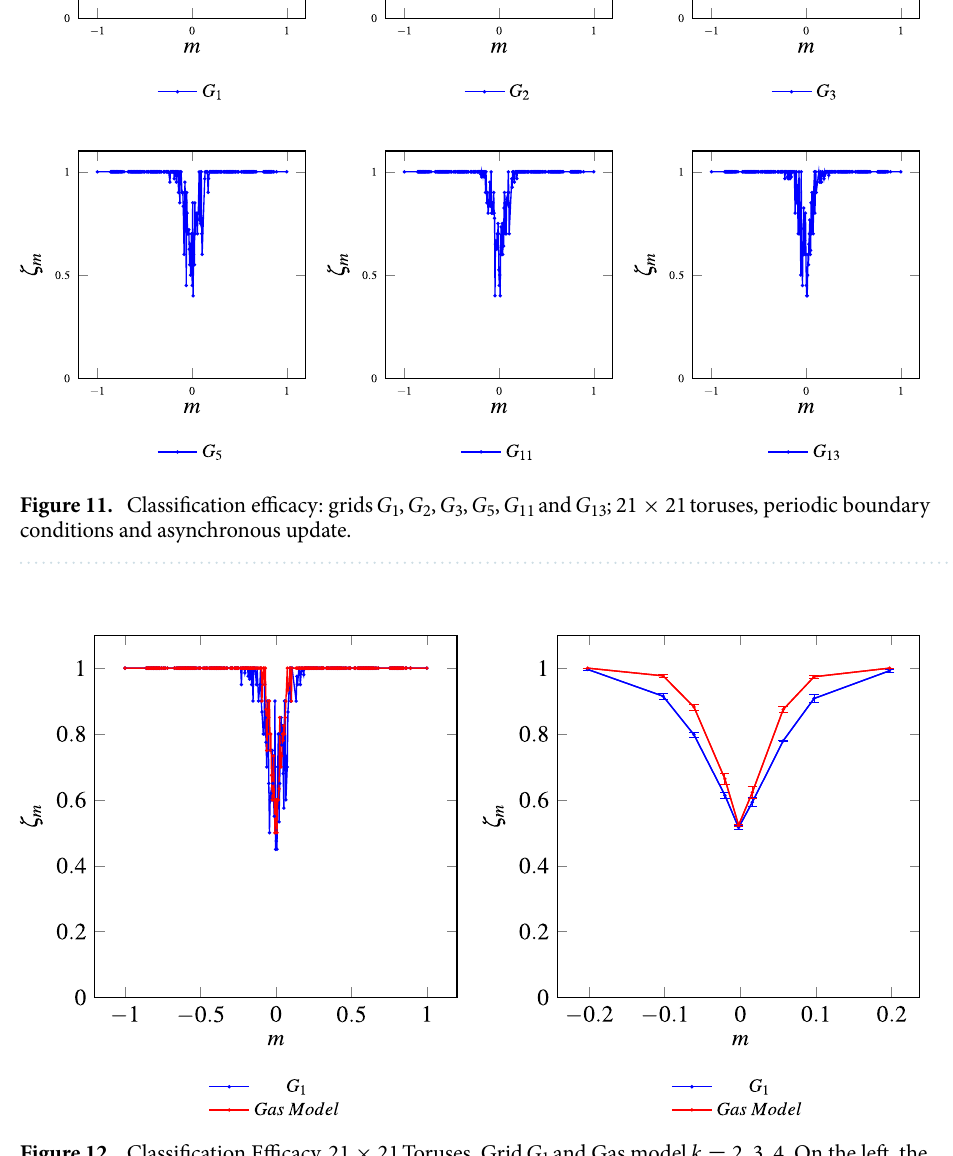
Figure 12. Classification Efficacy, 21 × 21 Toruses, Grid G 1 and Gas model k = 2 , 3, 4. On the left, the classification efficacy over the entire range of possible magnetizations. On the right, a point-by-point estimation using 10 3 initial configurations for each exact value of m over a smaller range [− 0.2, 0.2 ] . The simulation results are averaged over five independent realizations with error bars representing the standard